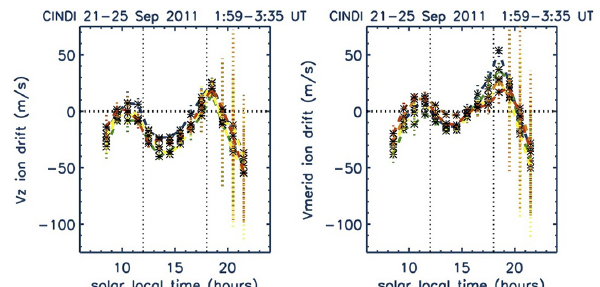
Figure 2. The left diagram shows the vertical flows from the orbital swaths in Fig. 1 after they have been grouped into 1h local time bins and averaged. The asterisks denote the averaged values and the colored lines connect the averages for the same day’s swath follow- ing the color scheme in Fig. 1. The vertical dots above and below the asterisks denote the magnitude of the standard deviations of the averages. Despite the 24h separating each set of averages and the variation in the locations, the overall pattern of the vertical flows is quite consistent. The diagram on the right shows the same analysis for the meridional flows in the magnetic coordinate system.